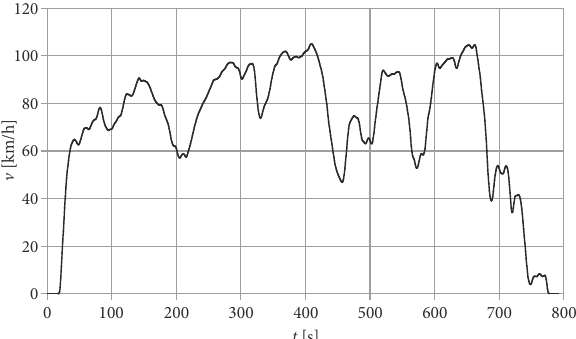
Figure 8. Vehicle speed v vs. time t curve in the RT1 test